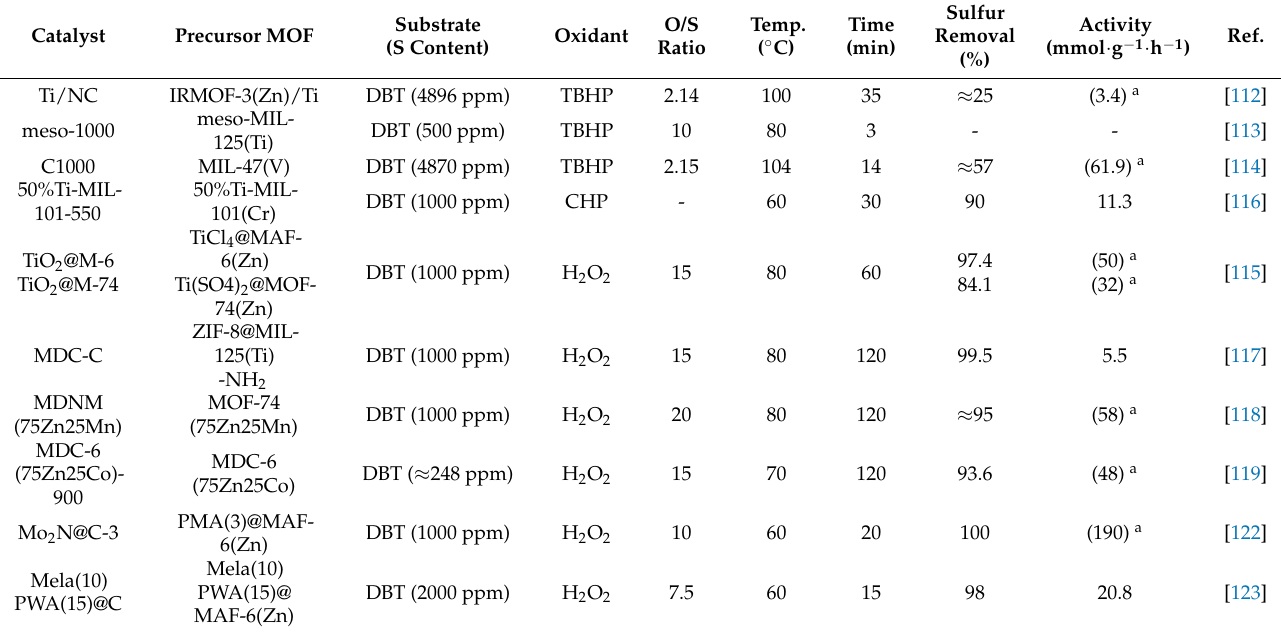
Table 6. Comparison of catalytic performance over MOFs-derived materials in the ODS reactions of model fuel oil.